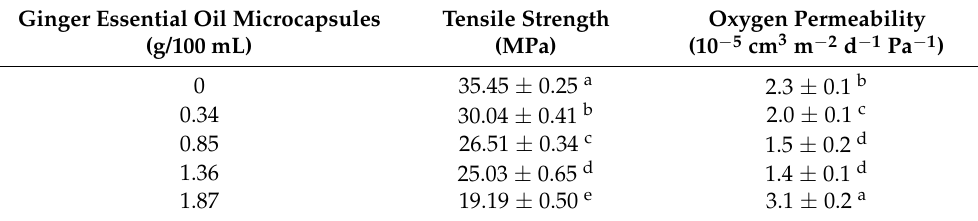
Table 2. Tensile strength and oxygen permeability of ginger essential oil microcapsule films. Ginger Essential Oil